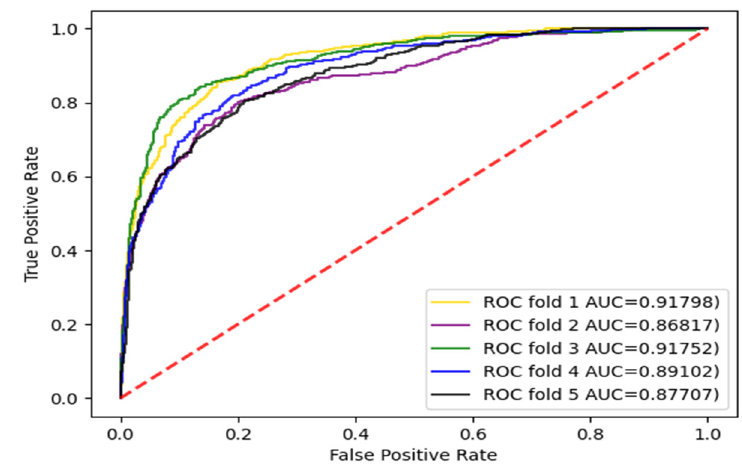
Figure 3. AUC curve of the enzyme dataset under CVD division.